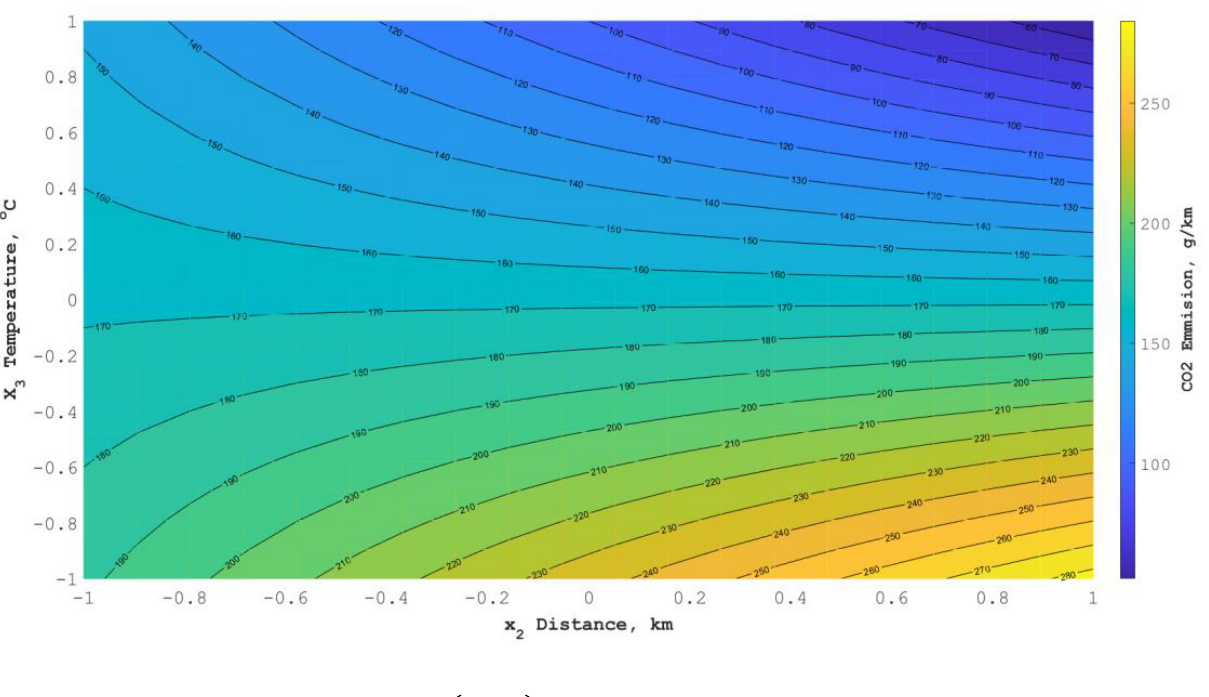
Figure 12. Change in CO 2 emissions depending on the variability of factors x 2 and x 3 for a vehicle (EV) moving for 20 min (x 1 = 0).